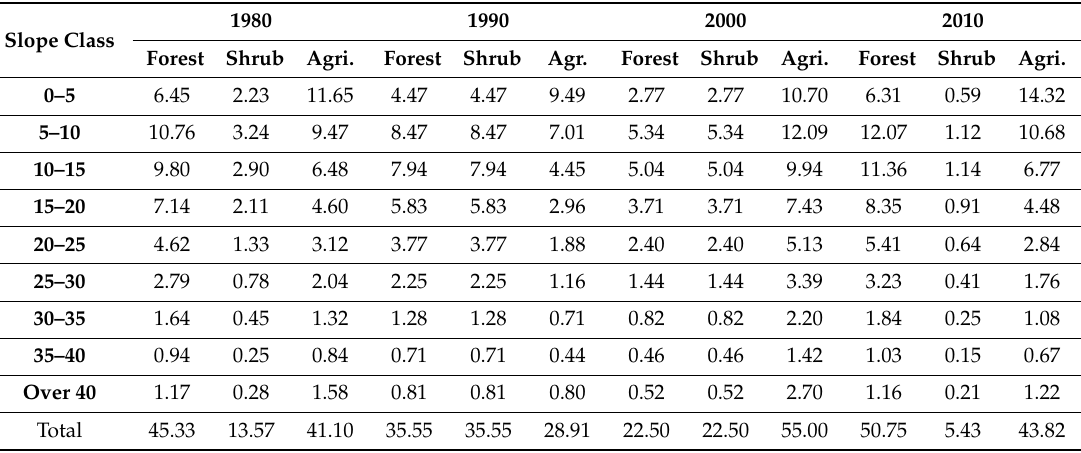
Table 7. Province 1: land use as a percentage of total area of forest, shrubland, and agriculture for 1980, 1990. 2000, and 2010 for entire Nepal. ((Individual land-use area for a slope class / sum of forest + shrubland + agriculture) * 100).